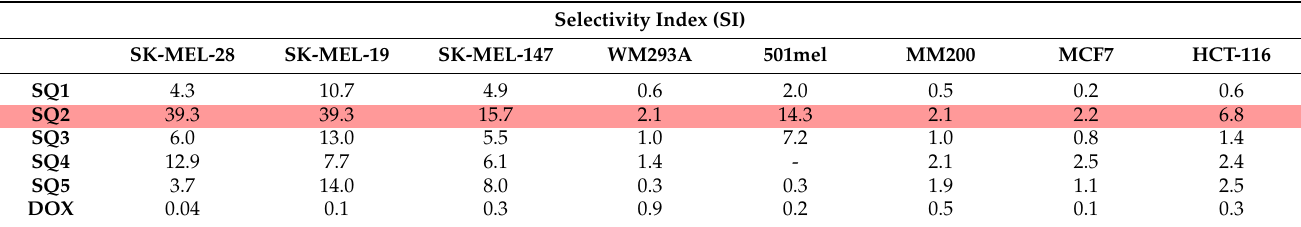
Table 1. Selectivity Index (SI) of SQ1 , the synthetic analogues ( SQ2–SQ5 ) and doxorubicin (DOX) for cancer (SK-MEL-19, SK-MEL-28, SK-MEL-147, WM293A, 501mel, MM200, MCF7, and HCT-116) versus normal fibroblast cells (MRC-5). Data is reported as the ratio of the respective 72-h IC 50 value to that of MRC-5 cells. Highlighted in red, SQ2 presented higher SI values than SQ1 .